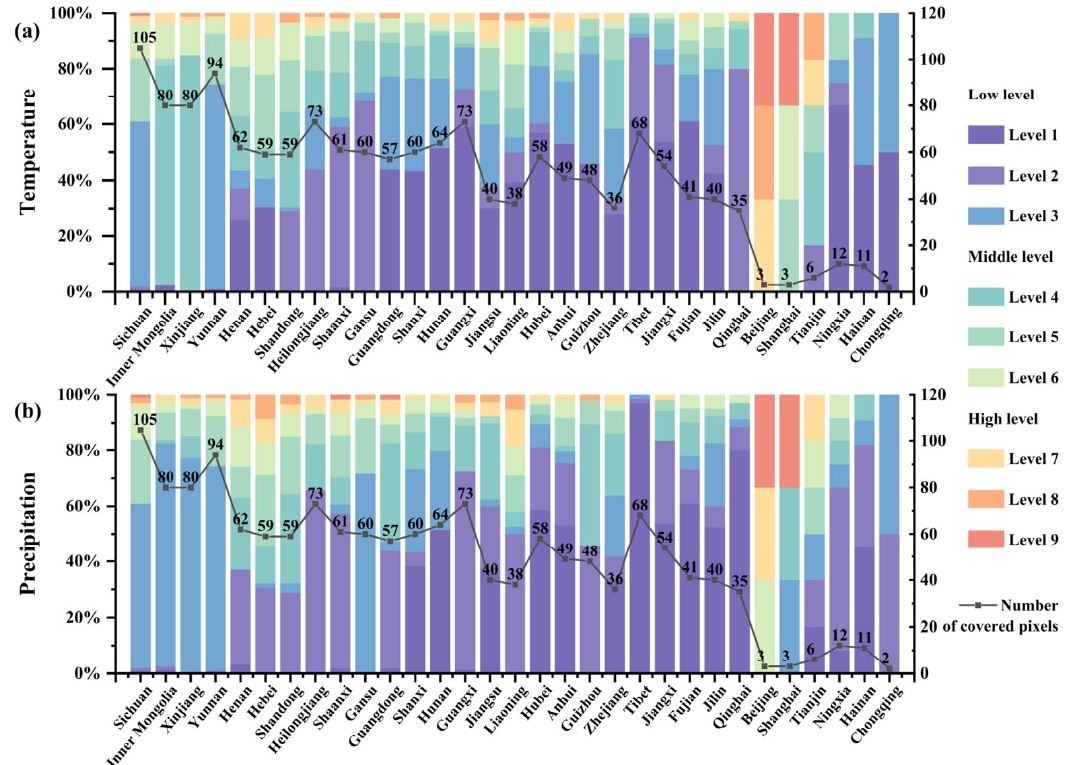
Figure 6. The percentages of samples for the impact of temperature and precipitation changes in 31 provinces. ( a ) The percentage of samples for the impact of temperature change in each province. ( b ) The percentage of samples for the impact of precipitation change in each province.